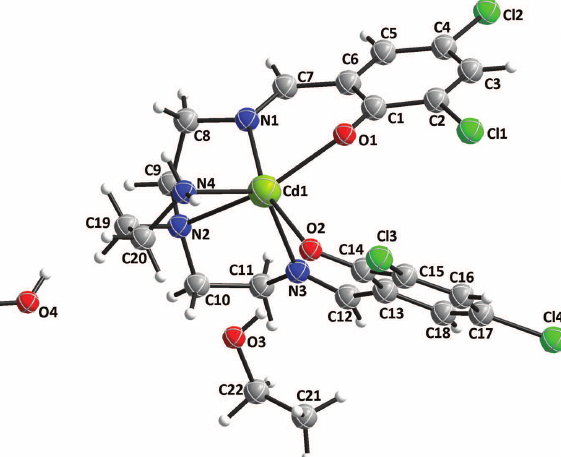
Table 1: Data collection and handling.